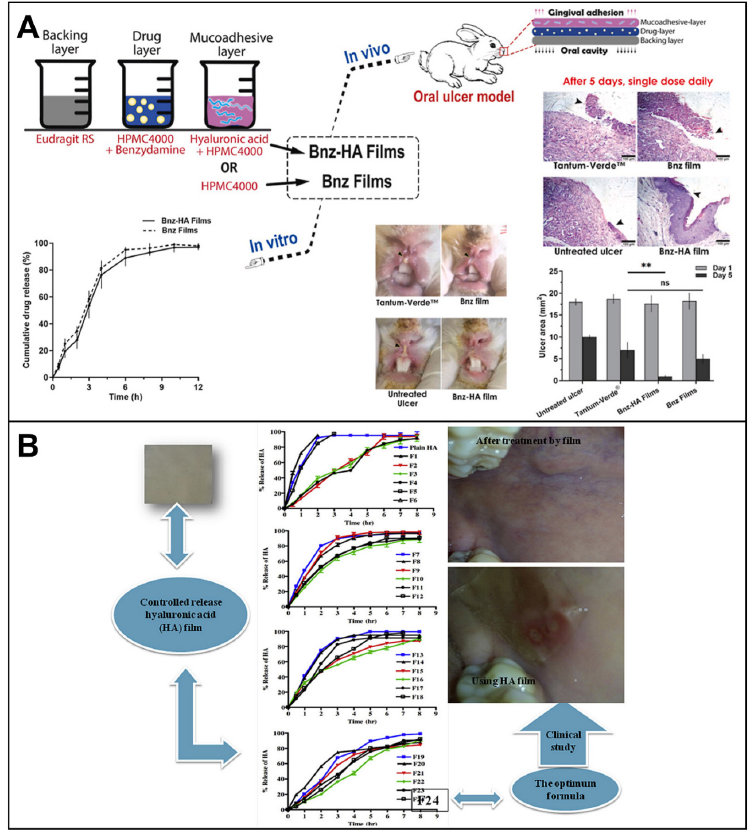
Figure 13. Preparation of oral adhesive films by solvent casting. ( A ) Bnz-HA films, reprint permis- sion from ref. [152]. Copyright 2021, Elsevier; ( B ) Oral mucosa adhesion film containing HA, reprint permission from ref. [108]. Copyright 2020,